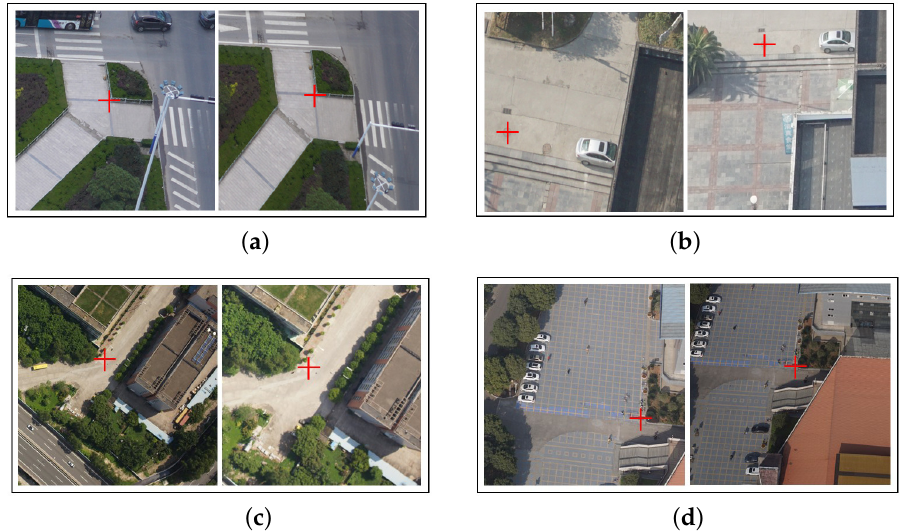
Figure 17. A sample of control points from four datasets. In each subplot, the left side is measured model coordinates , and the right side is outdoor ground control point coordinates. ( a ) Dataset 1. ( b ) Dataset 2. ( c ) Dataset 3. ( d ) Dataset